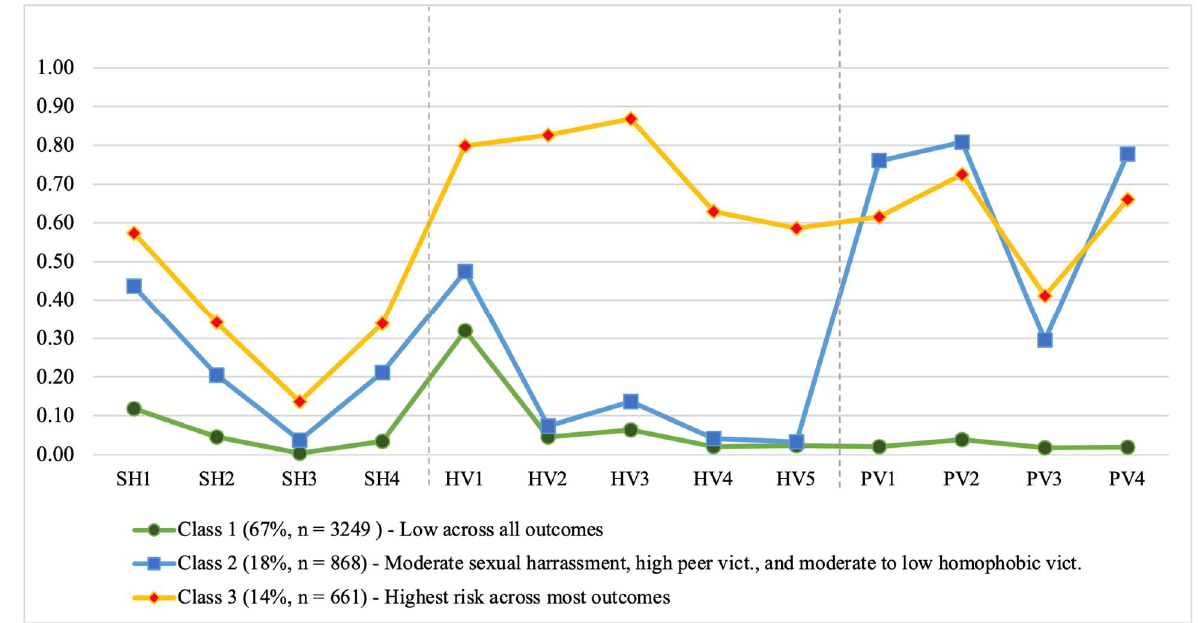
Figure 1. Graphical Representation of Endorsement Probabilities for each item by Latent Class (N = 4778). Note: Sexual Harassment: SHV1 = Made sexual comments, jokes, gestures, or